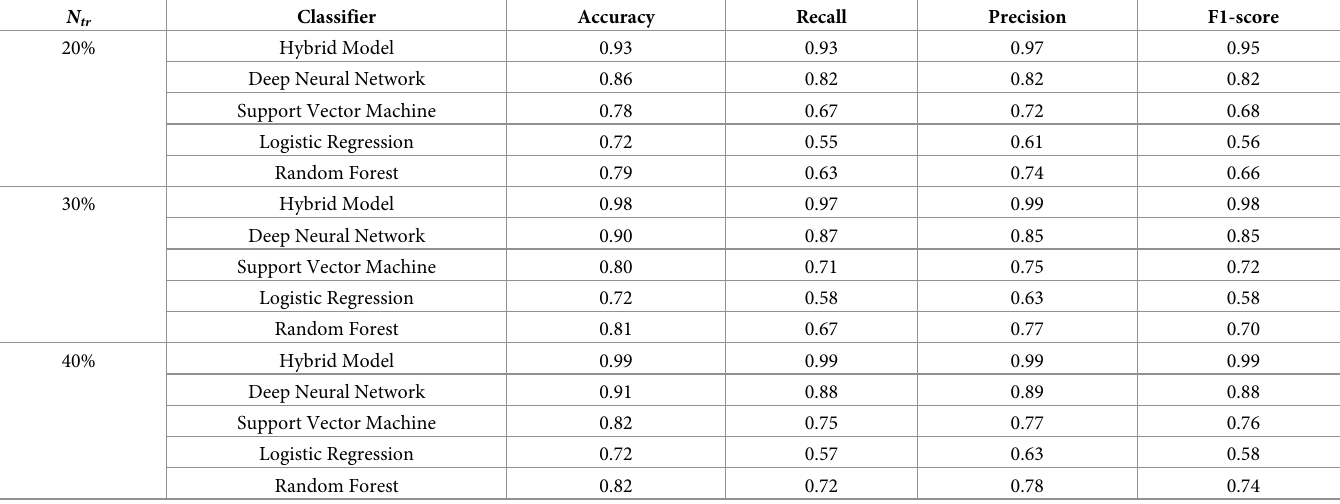
Table 4. The comparison of the median of the binary classification measurement results on the synthetic data. N